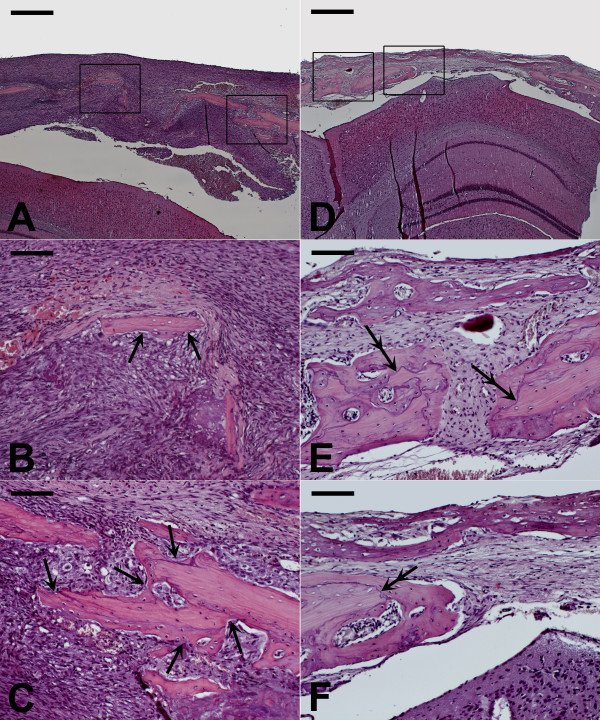
SW 1353 chondrosarcoma at day 28 after tumor implantation, hematoxylin-eosin stained cross section from representative tissue samples of the cranial window preparation. A, D: 4-fold magnification, scale bar 500 μm. B, C, E, F: 20-fold magnification, scale bar 100 μm. In Controls, the overview magnification shows a large tumor formation with high cellular density (A). Enlarged cutaway views (B, C) from the framed regions show high cellular density and destructive tumor growth with resorption of the surrounding bone (arrows, tips pointing to resorption lacunae). In SU6668, tumor size was markedly reduced (D). Enlarged cutaway views (E, F) from the framed regions show fibrous "scar" tissue with residual tumor cells and low cellular density and regenerative bone formation at sites of previous bone resorption (double arrows, distal tip pointing to former resorption front, proximal tip pointing to new mineralization front).